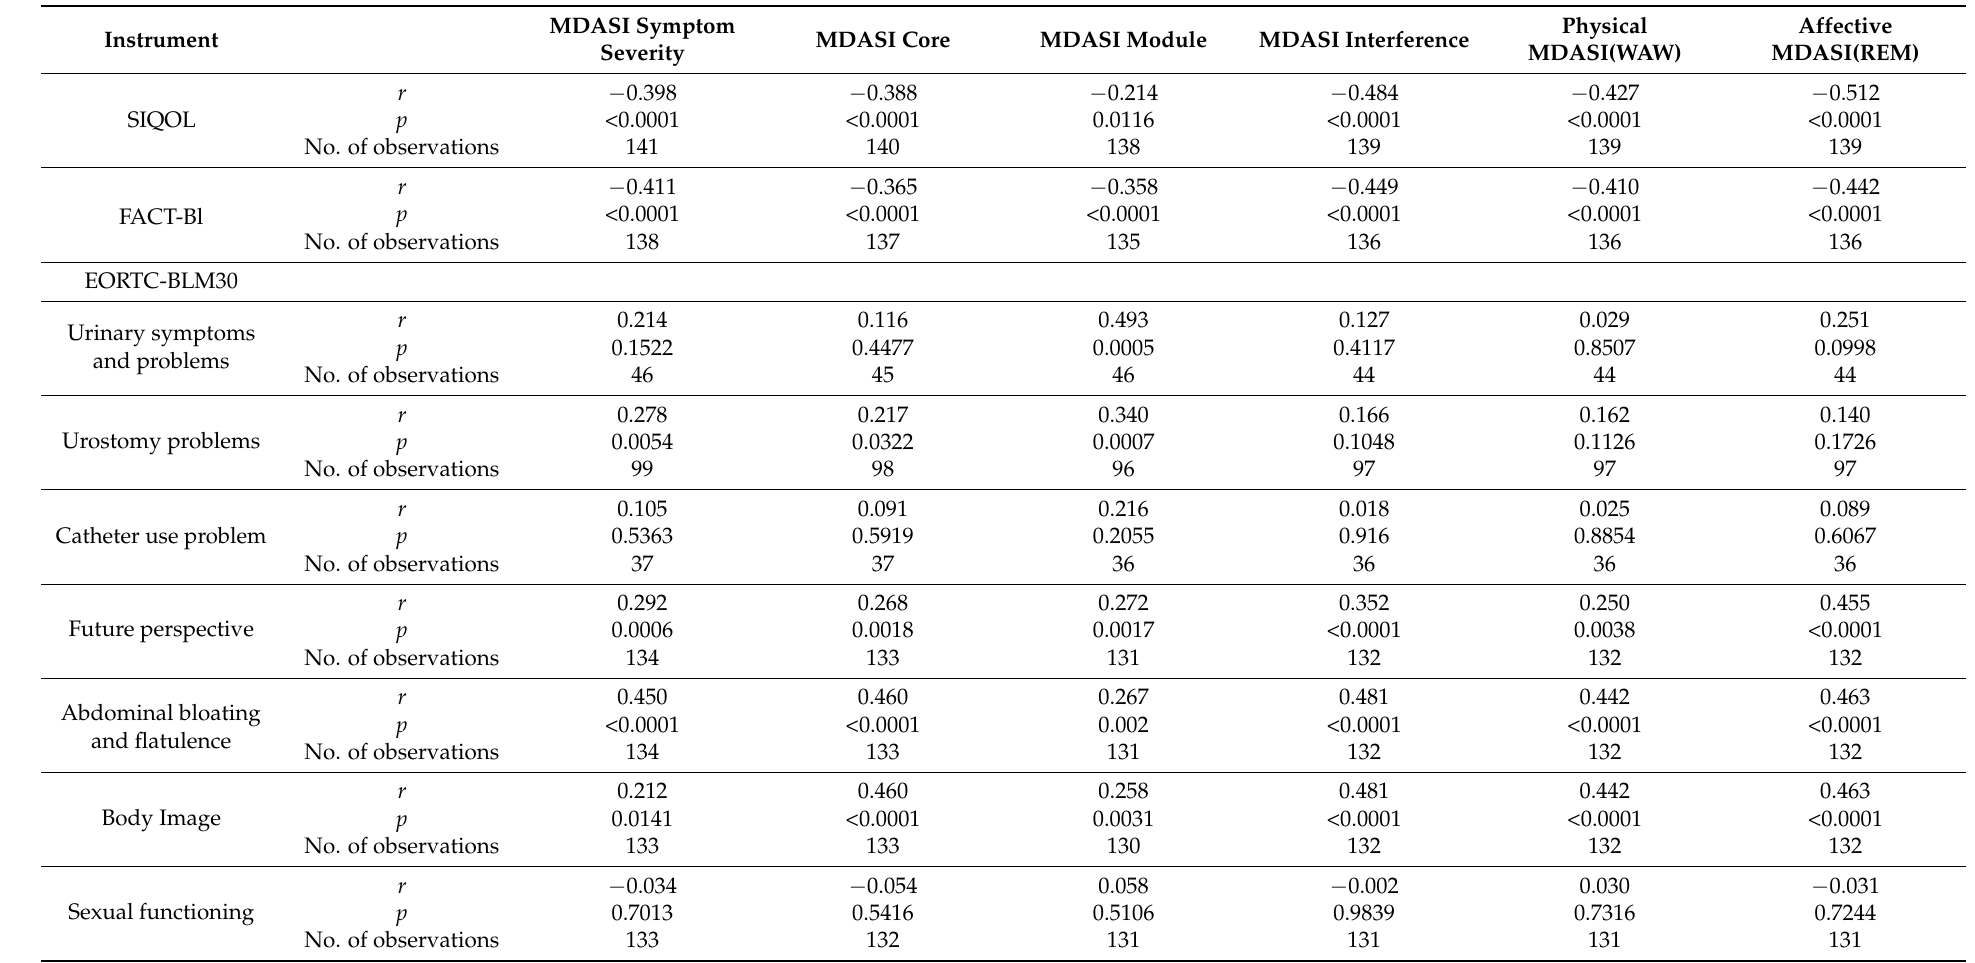
Table 4. Convergent validity of MDASI subscales using other validated